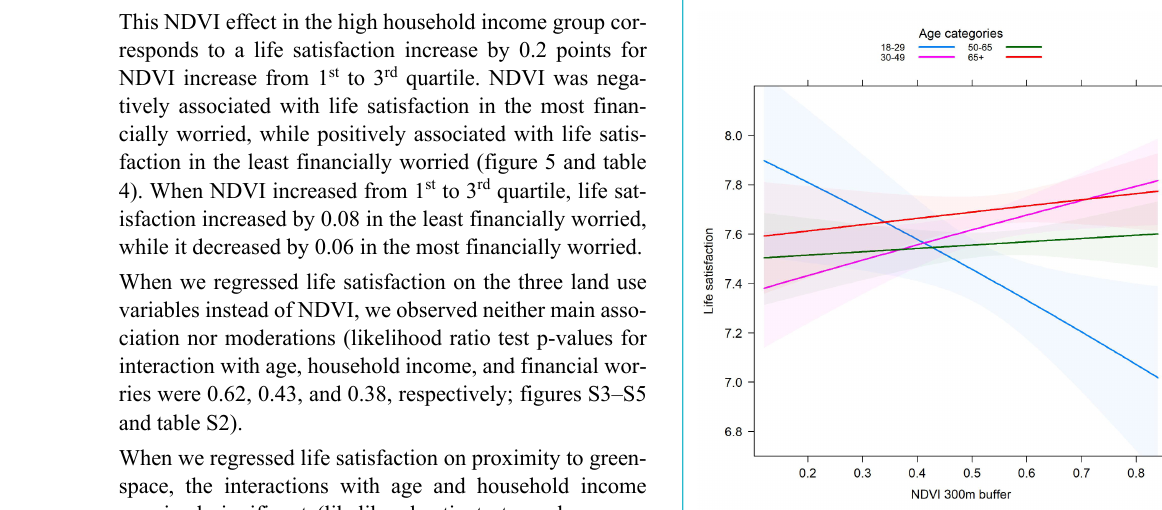
Figure 3: NDVI association with life satisfaction by age categories, adjusted for life satisfaction in the past, sex, household income, fi- nancial worries, canton, degree of urbanisation, and month of en- try.